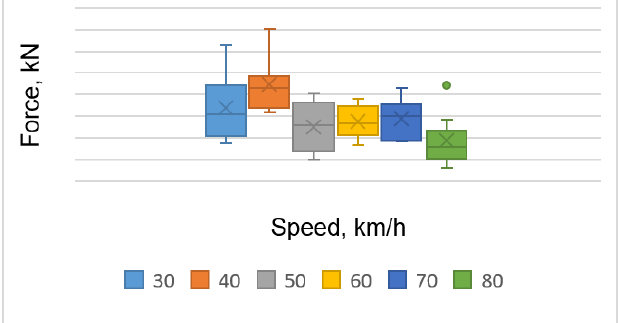
Figure 22. Maximal force values of unloaded goods wagon.